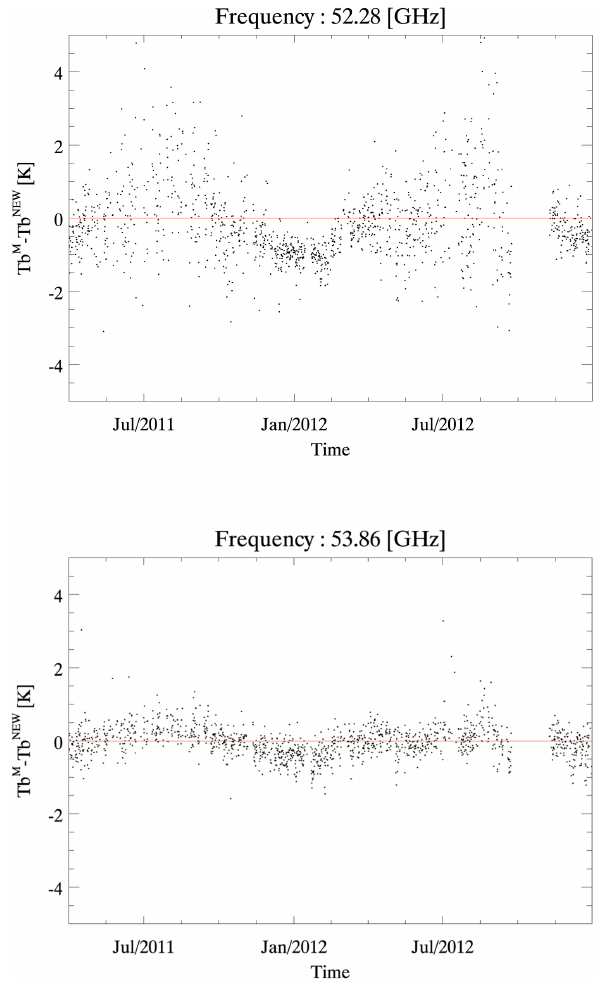
− T new (after the frequency shift). b b